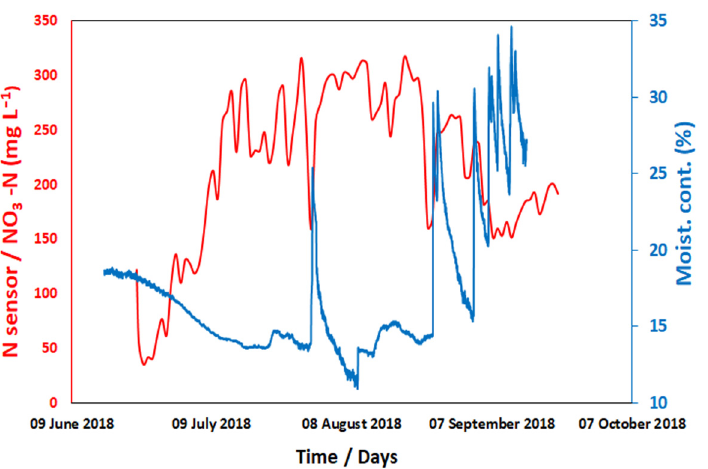
Figure 4. Soil nitrate concentration (at 10 cm depth) was measured over a period of three months by N sensors plotted alongside soil moisture data from soil moisture sensor (Acclima TDT-SDI-12 soil moisture sensor). (See Table S3).